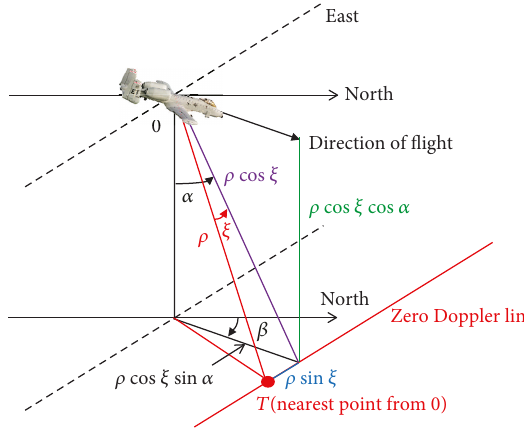
Figure 7: Relative position to the nearest